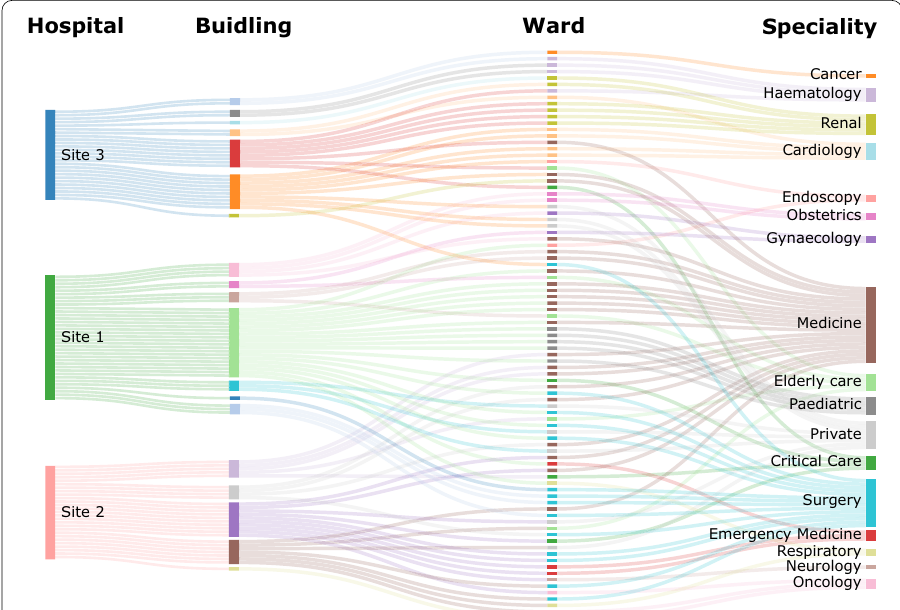
Fig. 2 Sankey diagram of Trust Structure traversed by CPE patients. Broken down by hospital site, and buildings to wards, then also broken down by speciality into